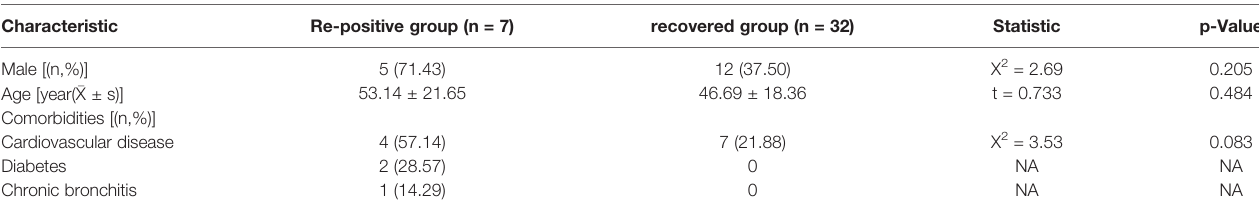
TABLE 1 | Baseline characteristics of re-positive patients with COVID-19.